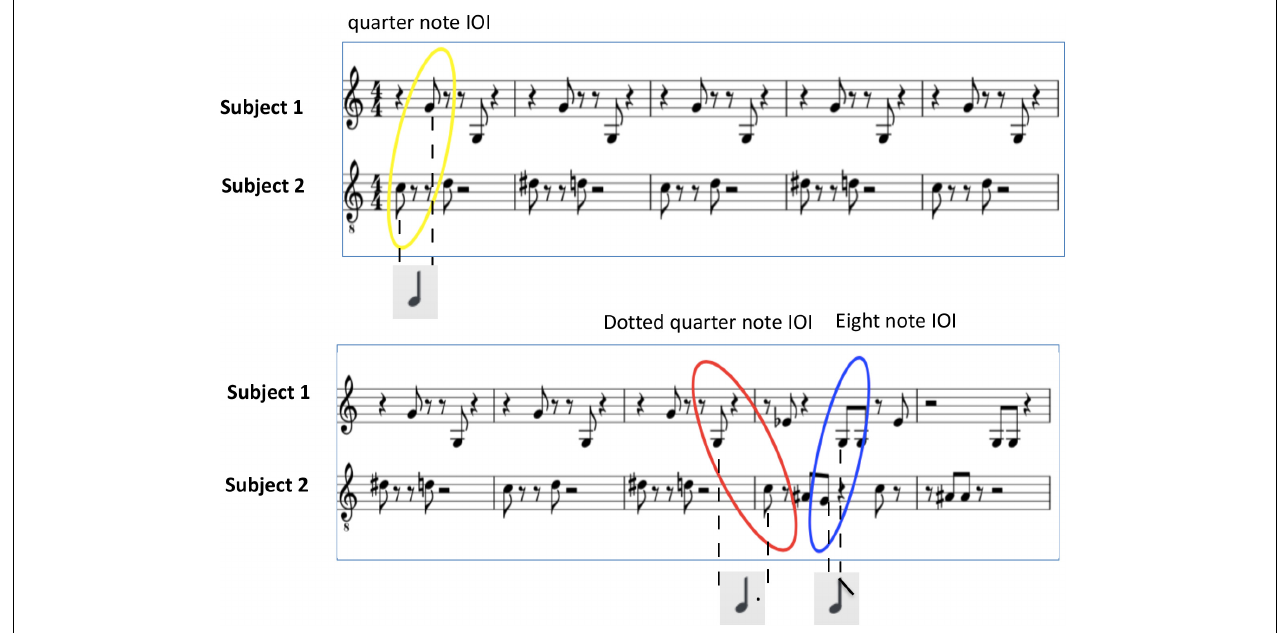
FIGURE 1 | Experimental stimulus. Part of the participants’ scores. Together these scores form a semi-hocket, meaning that there are no simultaneous notes, and the combined scores merge into one melody. This melody is an adaptation of Michael Jackson’s Billy Jean. The two parts contain an equal number of notes, displaying the same level of difficulty. In yellow, red and blue the three IOIs used in Bayesian regression (see below) are